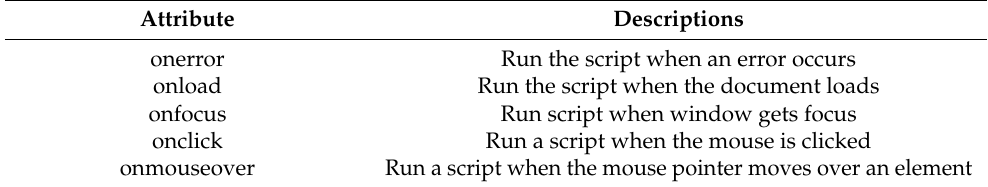
Table 3. Some on-events and descriptions.